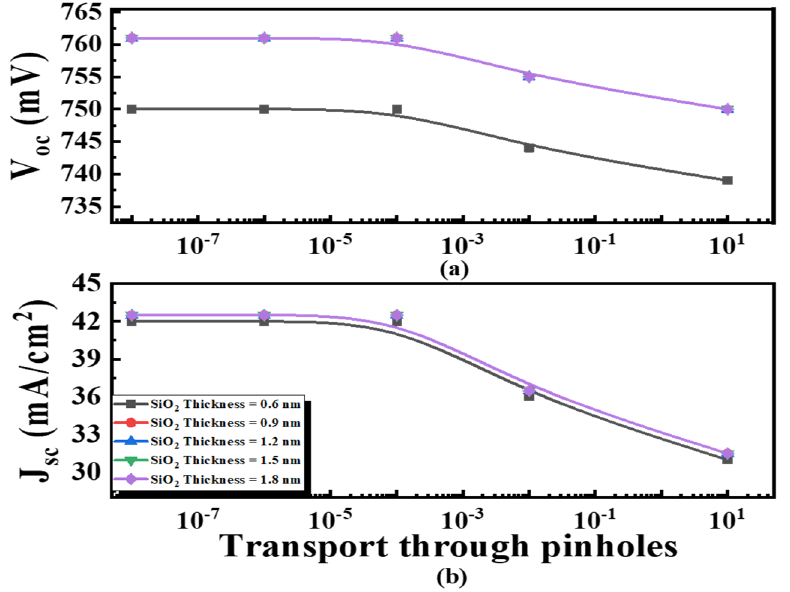
Figure 10. Effect of pinholes density (1 × 10 − 7 –1 × 10 1 ) with various oxide thicknesses (0.6–1.8 nm) on ( a ) V oc and ( b ) J sc on the TOPCon solar cell.